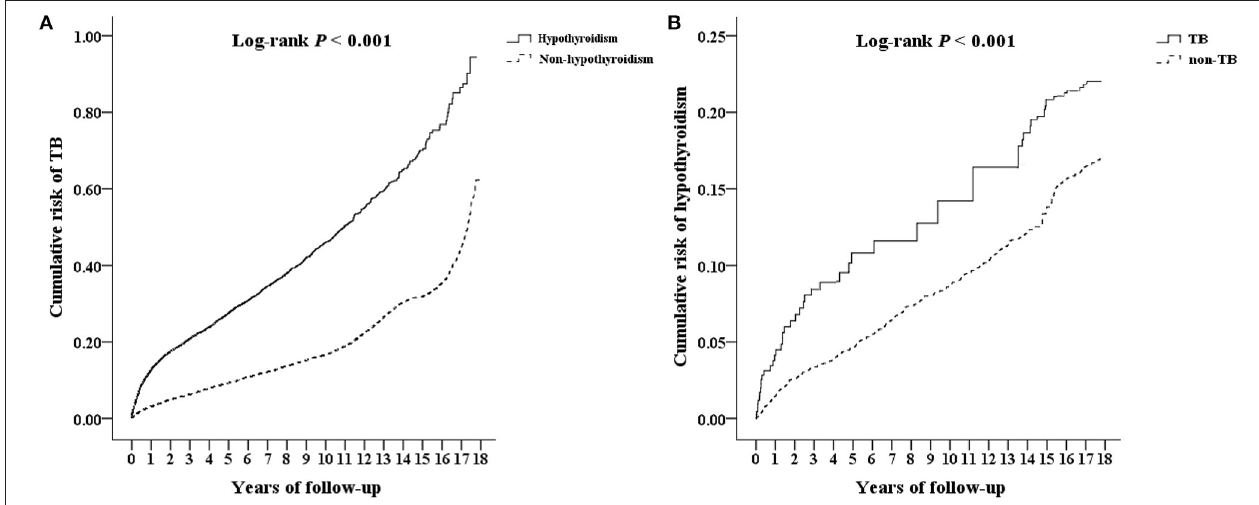
FIGURE 2 | Kaplan–Meier analysis for cumulative risk of developing (A) TB and (B) hypothyroidism among patients aged ≥ 20 years using log-rank test. TB, tuberculosis.